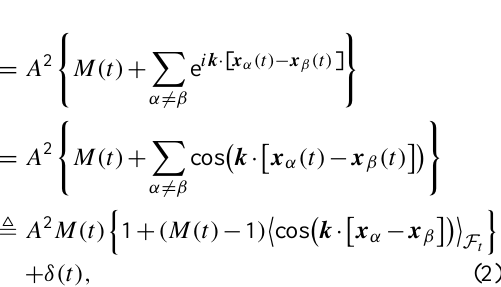
Fig. 2. (a) CLVIS keogram, (b) altitude/time/intensity from Beam 3 of